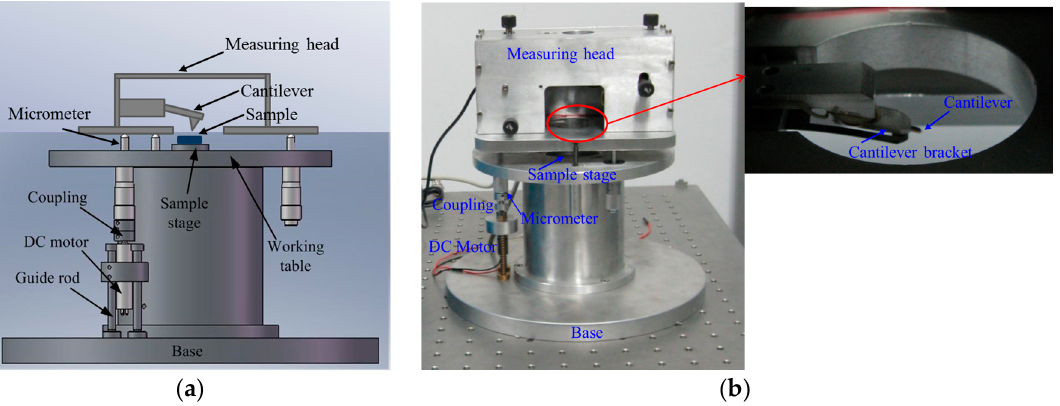
Figure 4. The cantilever–sample approach system: ( a ) Schematic diagram ( b ) Experimental set-up.